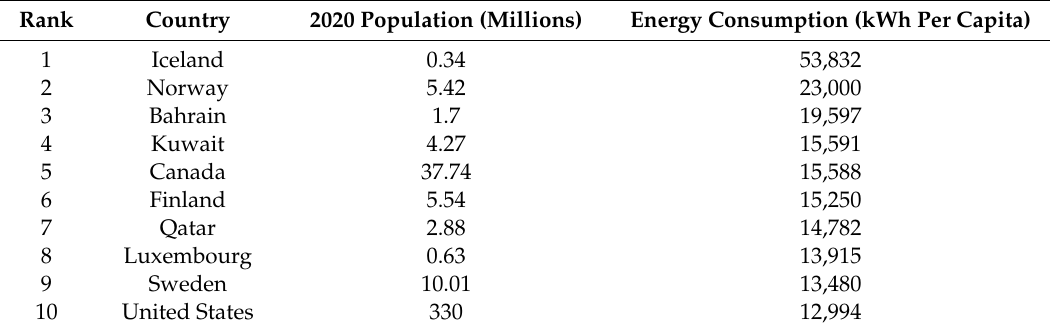
Table 2. Top 10 consumers of electricity per capita